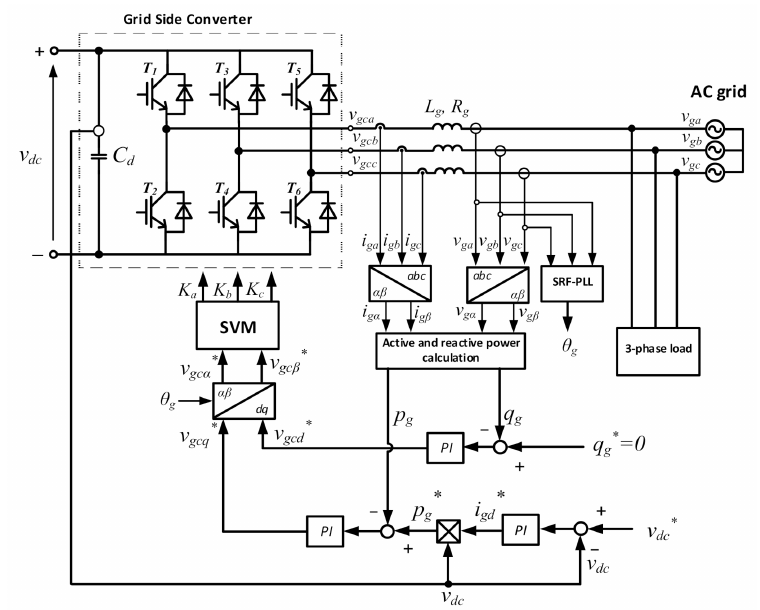
Figure 14. The detailed scheme of Grid Side Converter (GSC) with applied Direct Power Control- Space Vector Modulation (DPC-SVM)